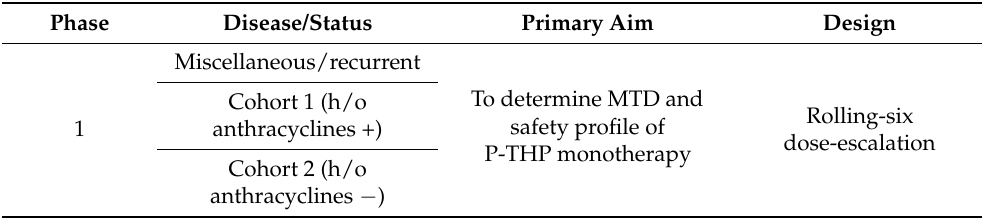
Table 1. Clinical development of P-THP for pediatric solid